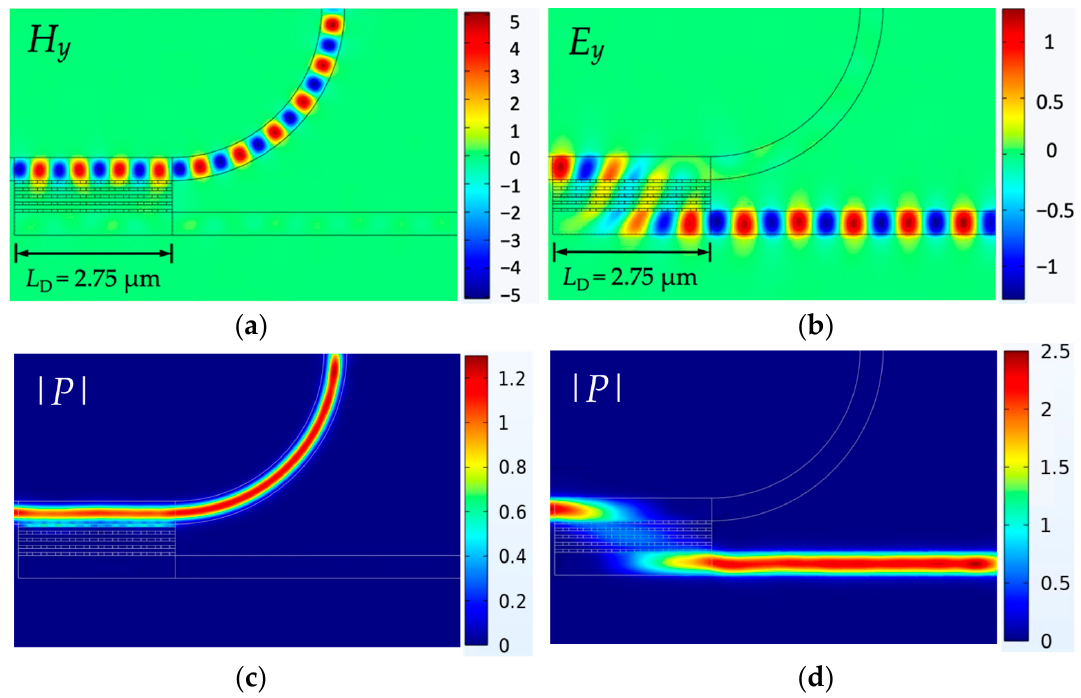
Figure 5. y components of ( a ) magnetic field of the TE mode and ( b ) electric field of the TM mode, and the total power evolutions of the ( c ) TE and ( d ) TM modes of the present structure with device length L D = 2.75 μ m (i.e., the practical L c,TM with optimal performance) for t s = 60 nm, h Si = 150 nm, W Cl = 75 nm, W Si = 400 nm, g = 50 nm, s = 550 nm, and λ = 1550 nm.